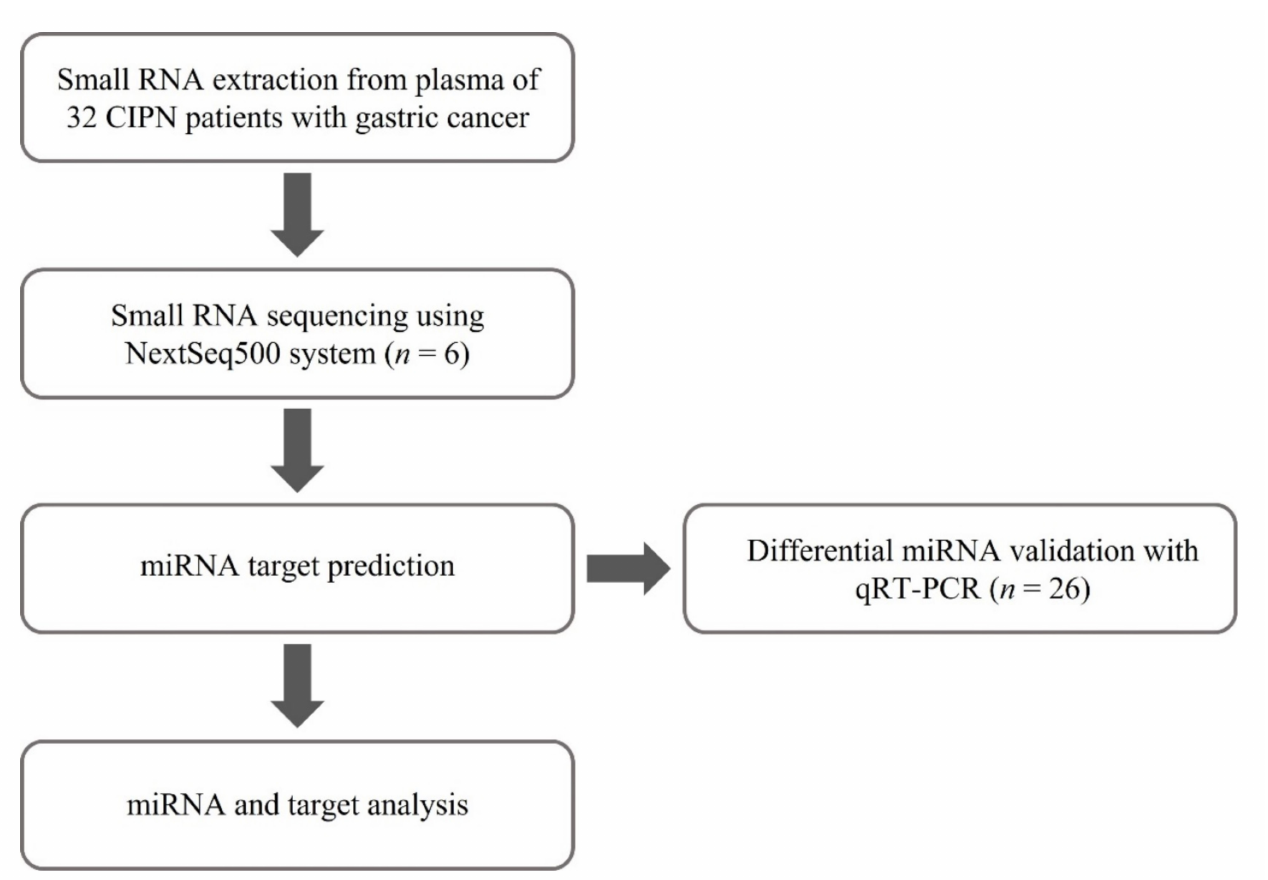
Figure 6. Overview of the analysis pipeline in this